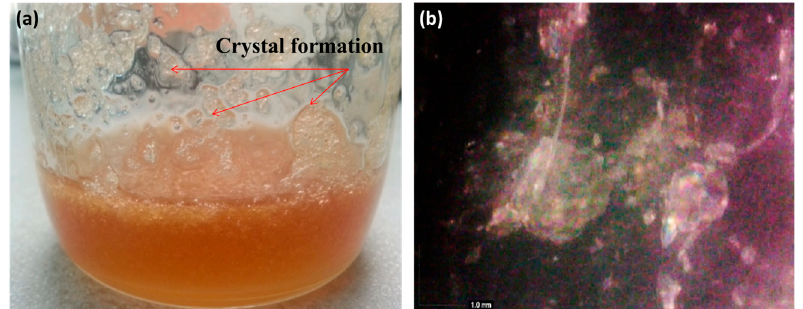
Figure 5. Images of crystal formation of 80% TSC AG by ( a ) the naked eye and ( b ) optical microscopy of aggregation of AG by Dino-Lite at a magnification of 50×.